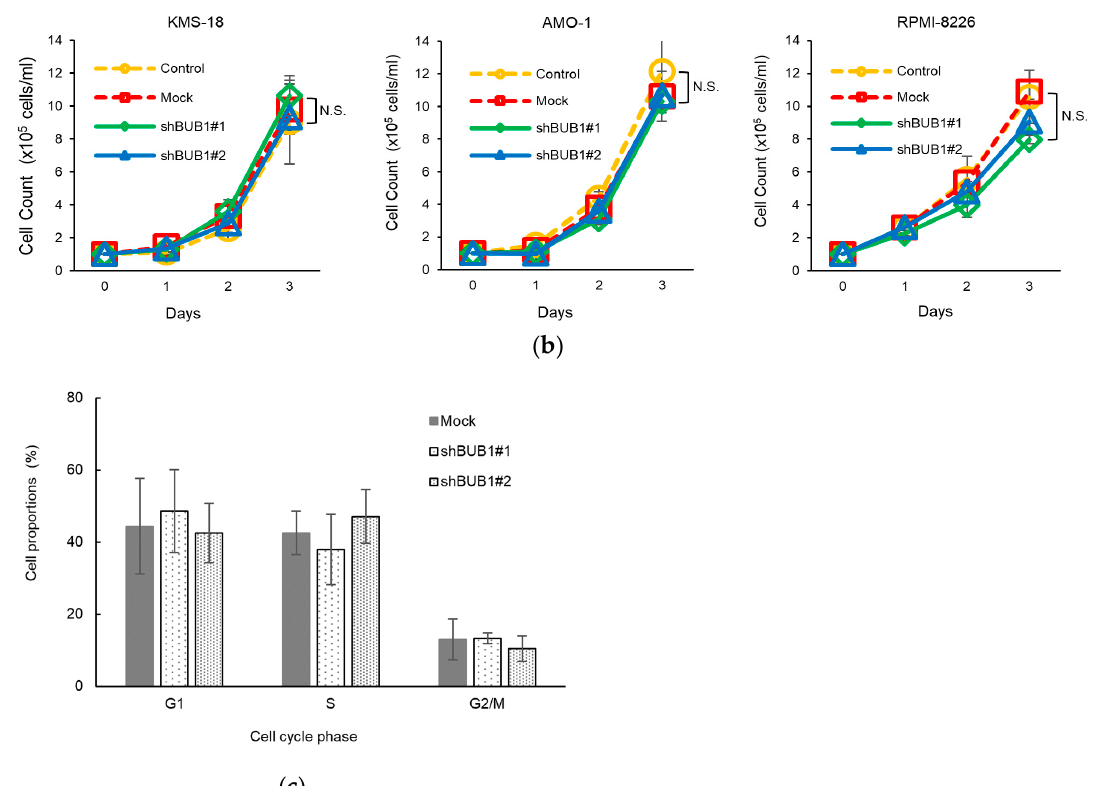
Figure 3. BUB1 expression did not affect the short-term proliferation of HMCLs. ( a ) Association between cell proliferation rates and BUB1 mRNA levels in HMCLs. Fold changes in cell numbers over three days of culture are plotted on the horizontal axis, and BUB1 mRNA levels relative to those in normal plasma cells (PCs) are on the vertical axis. Ten HMCLs were examined. ( b ) Cells were seeded at 1 × 10 5 cells/mL and grown in the complete liquid culture medium. Cell number was measured by Trypan blue dye exclusion assay over time. Dotted lines show growth of control (yellow circle) and mock-treated (red square) cells, and solid lines show BUB1-reduced cells using shBUB1#1 (green diamonds) and shBUB1#2 (blue triangles). Assays were performed in triplicate, and cell counts are expressed as means ± SD. N.S.: not significant. ( c ) BUB1 knockdown had no effect on cell cycle distribution in HMCLs. Data shown are the representative results with KMS-18 cells. The percentages of cell populations in the G1, S, and G2/M phases of the cell cycle are shown. Data are means ± SD from three independent experiments.